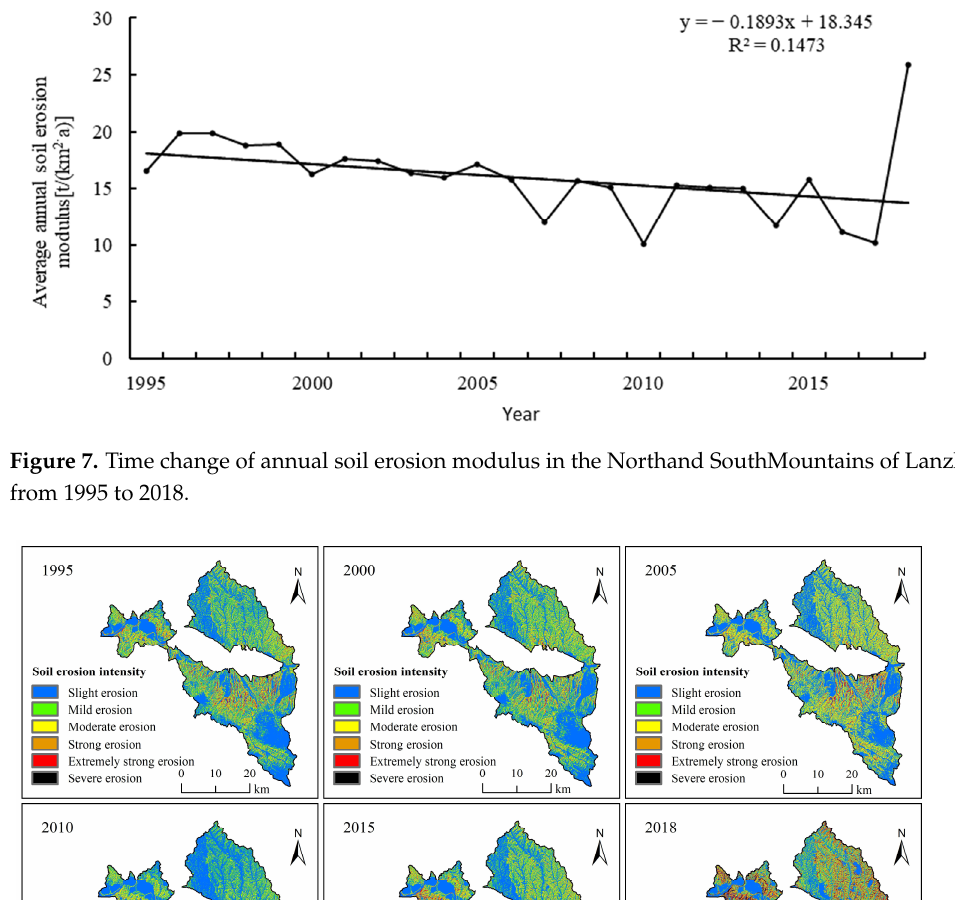
Figure 9. Chordal graph of soil erosion intensity in South and North Mountains of Lanzhou from 1995 to 2018 (Note: A: slight erosion; B: mild erosion; C: moderate erosion; D: strong erosion; E: extremely strong erosion; F: severe erosion).